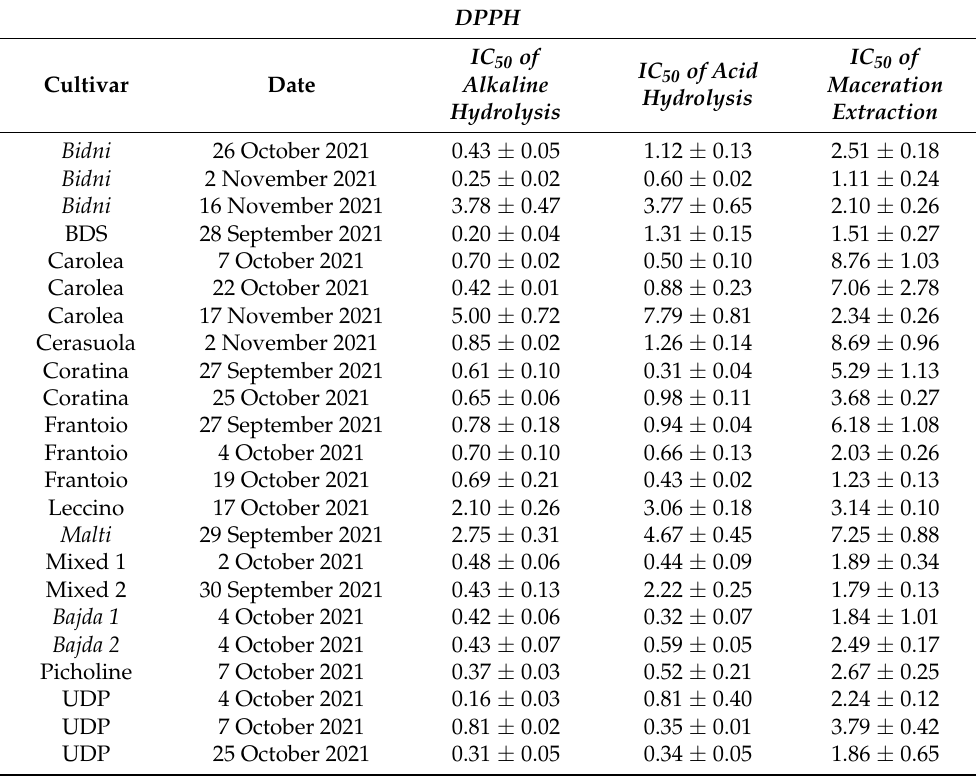
Table 1. C 50 s of olive oil extracts for DPPH Radical Scavenging activity. (BDS—Bella di Spagna and UDP—Uovo di